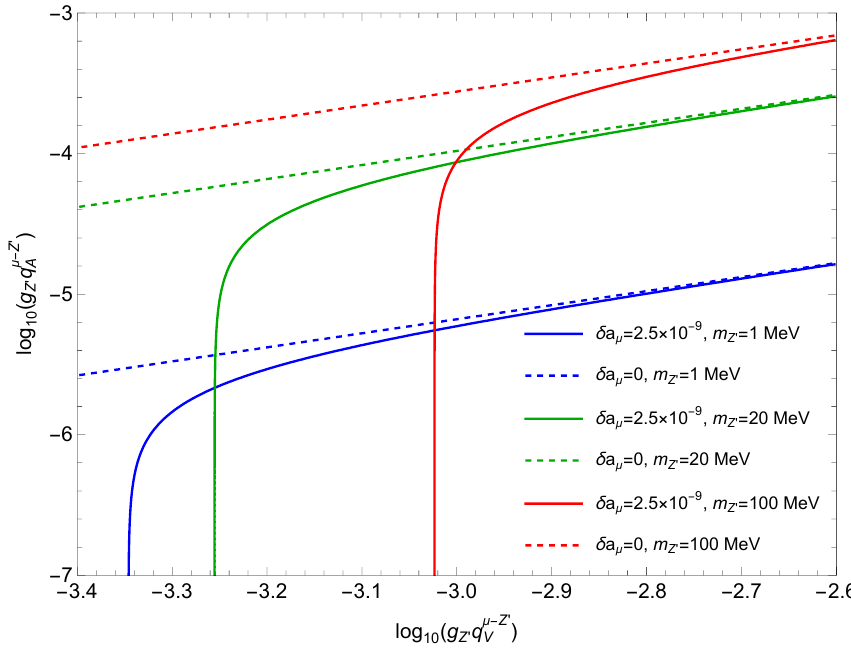
µ − Z 0 , for fixed values of δa Z 0 q V